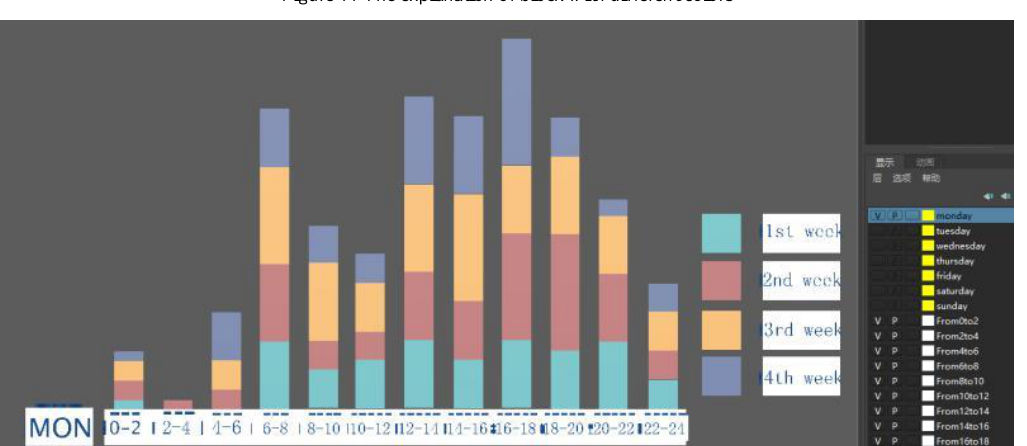
Figure 11 The explanation of block with different colors